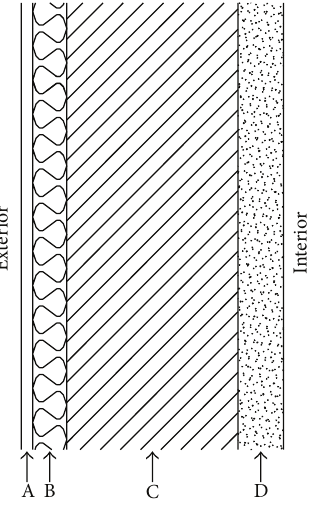
Figure 2: Wall configuration.